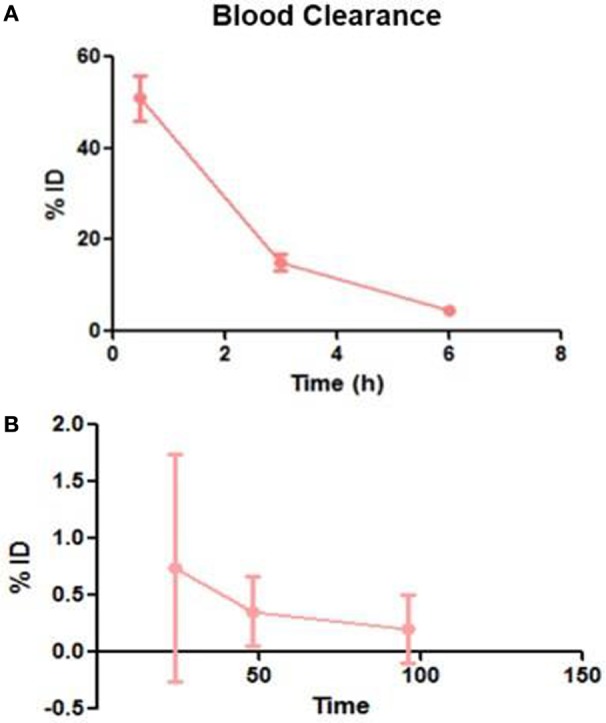
Blood clearance pattern of 153Sm-EDTMP. (A) Percent fraction of the injected dose (%ID) remaining in blood over the first 6 h (B) over the next 96 h.